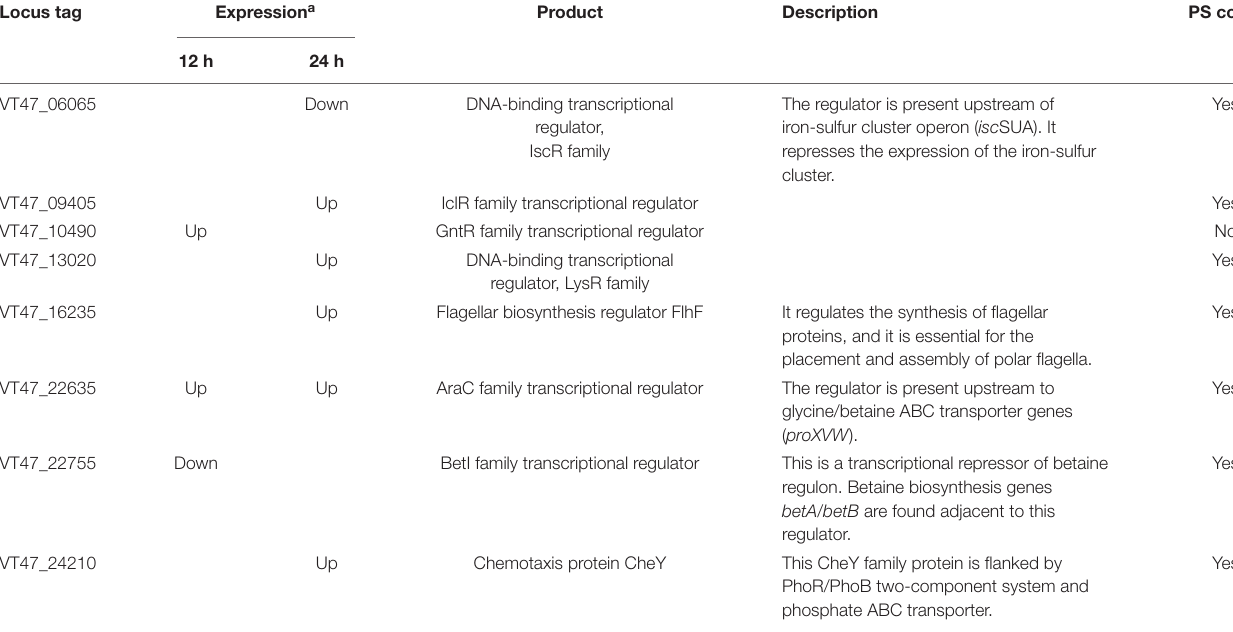
TABLE 4 | Expression profile of selected transcriptional regulators and their